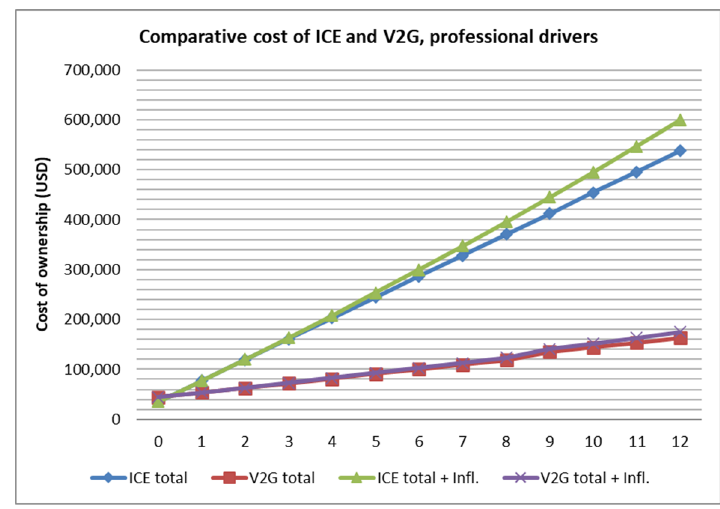
Figure 2. Graphical representation of the calculation results for professional drivers.